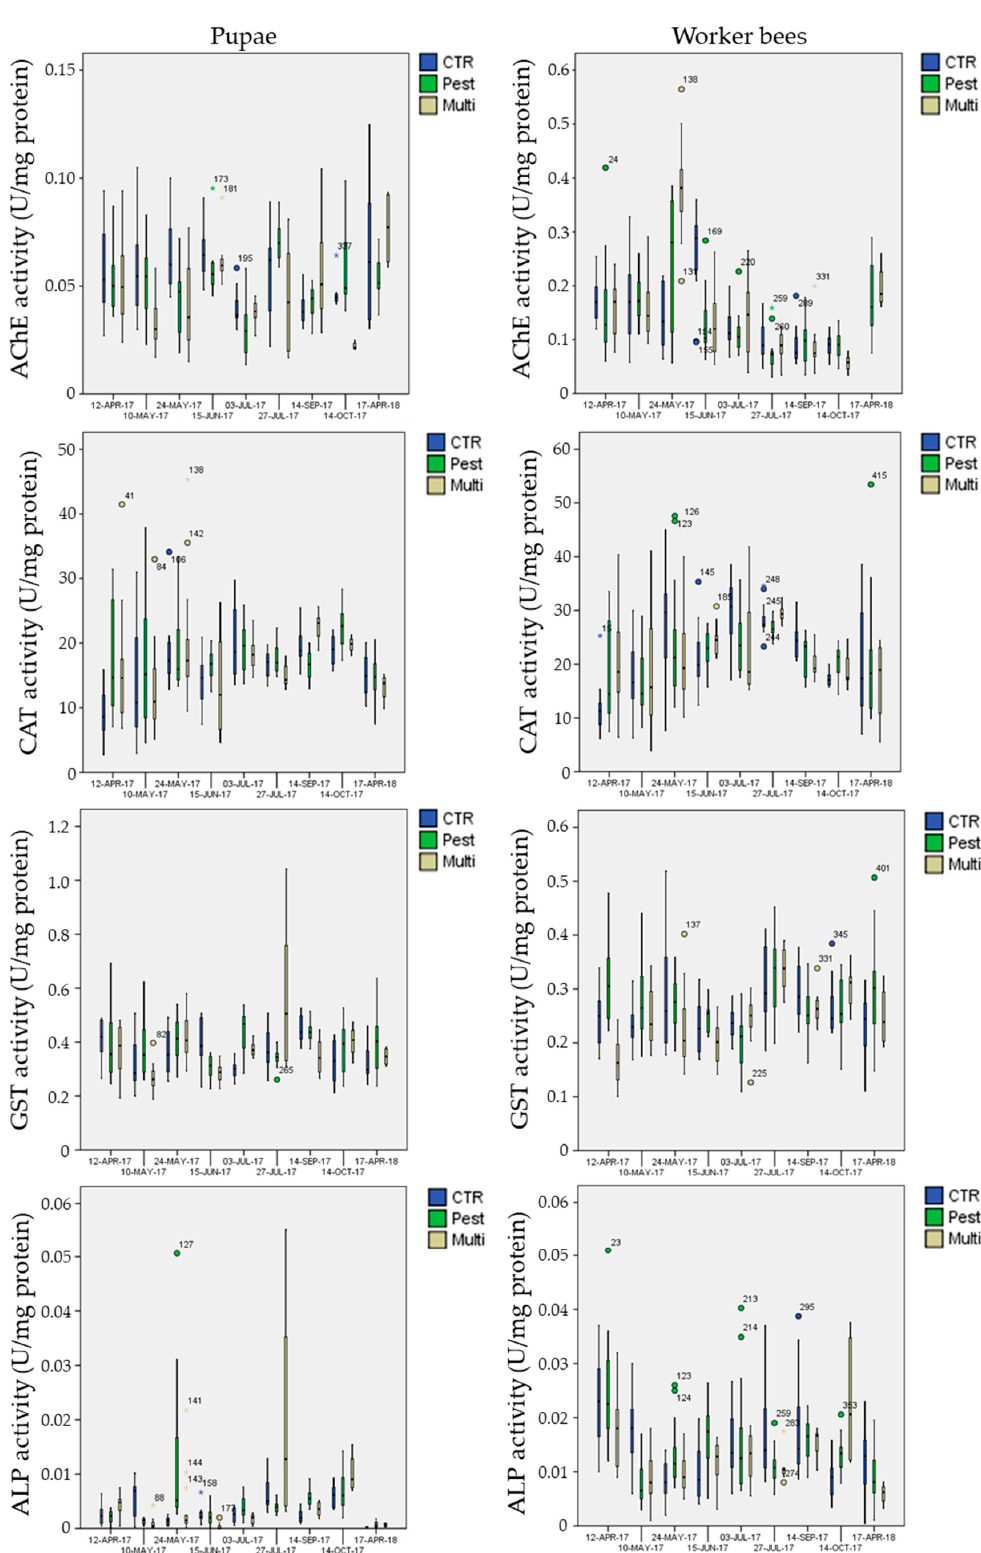
Figure 8. Box-plot of AChe, CAT, GST and ALP activity in the three experimental sites for pupae and worker bees as a function of the sampling